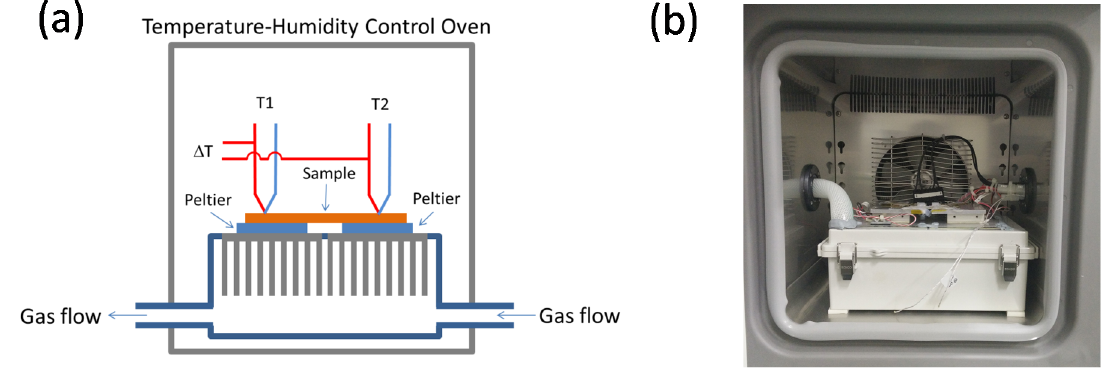
Figure 3. ( a ) Schematic and ( b ) photographic images of the Seebeck measurement setup in high-humidity conditions. Reproduced with permission from [31]. Copyright 2014 Japan Society of Applied